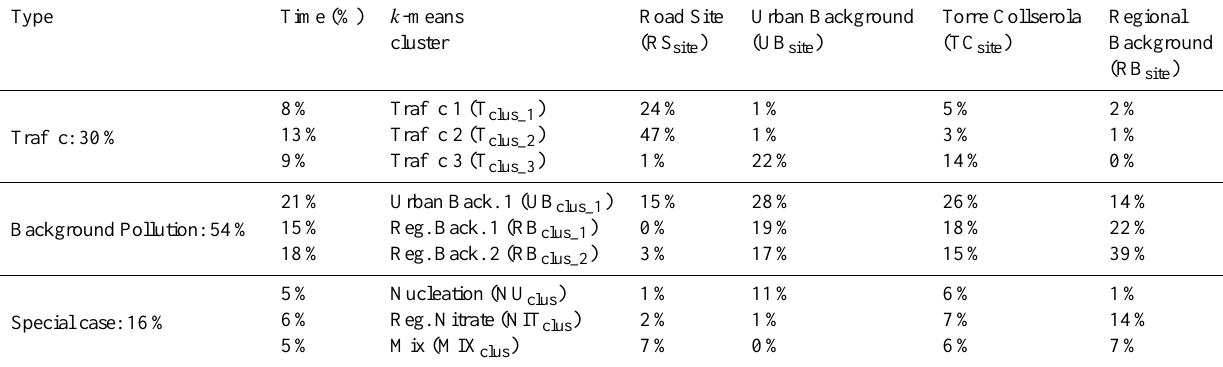
Table 1. Overall occurrence (%) of each cluster, classified into different scenarios as well as at each site (RS site , UB site , TC site and RB site ). Type Time (%) k -means Road Site Urban Background Torre Collserola Regional cluster (RS site ) (UB site ) (TC site ) Background (RB site